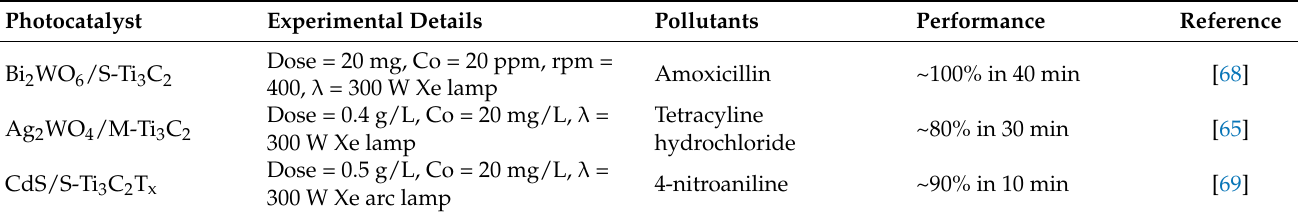
Table 2. Photocatalysis studies of different pollutants using MXene-based photocatalysts. Photocatalyst Experimental Details Pollutants Performance